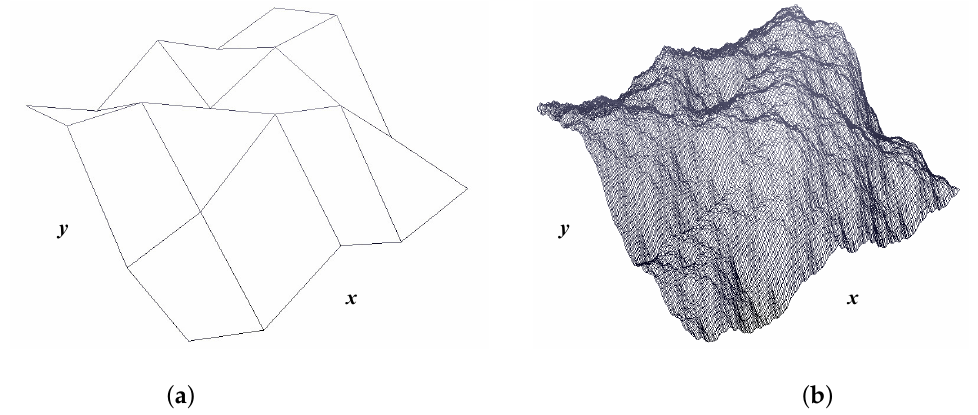
Figure 13. ( a ) The interpolation knot points. ( b ) The fractal interpolation